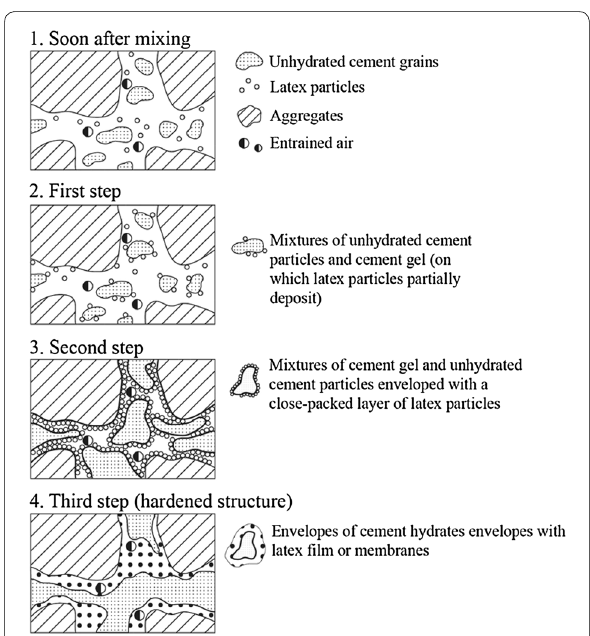
Fig. 4 Process of polymer film formation (adopted from Su